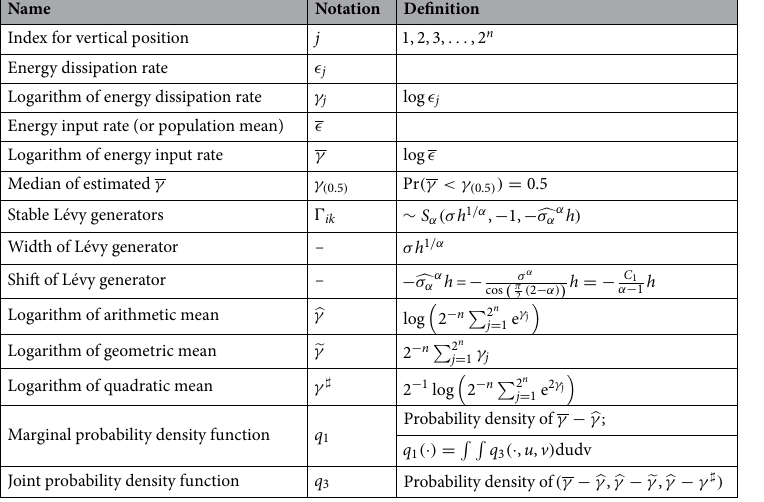
Table 1. Notation for the estimation